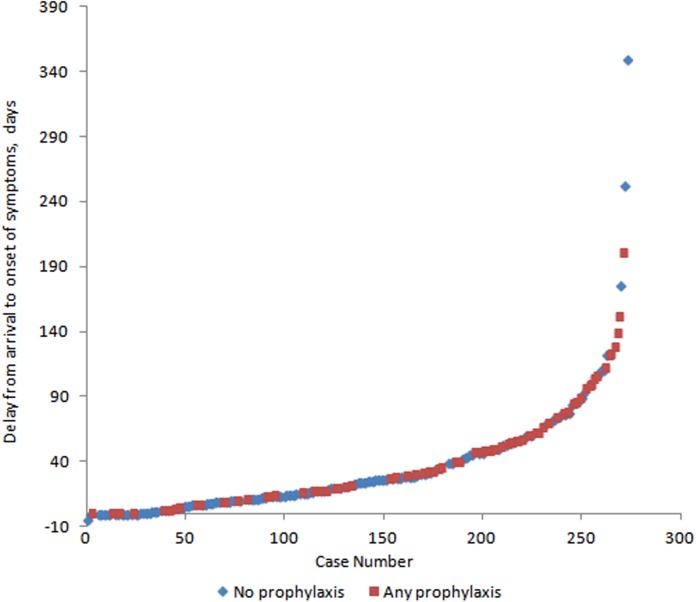
Delay to onset of symptoms in 273 P. malariae patients presenting with imported malaria in China, Sweden and the UK.Blue markers denote those reporting no chemoprohylaxis use. One outlier from the UK dataset (delay to onset: 1123 days) was excluded.